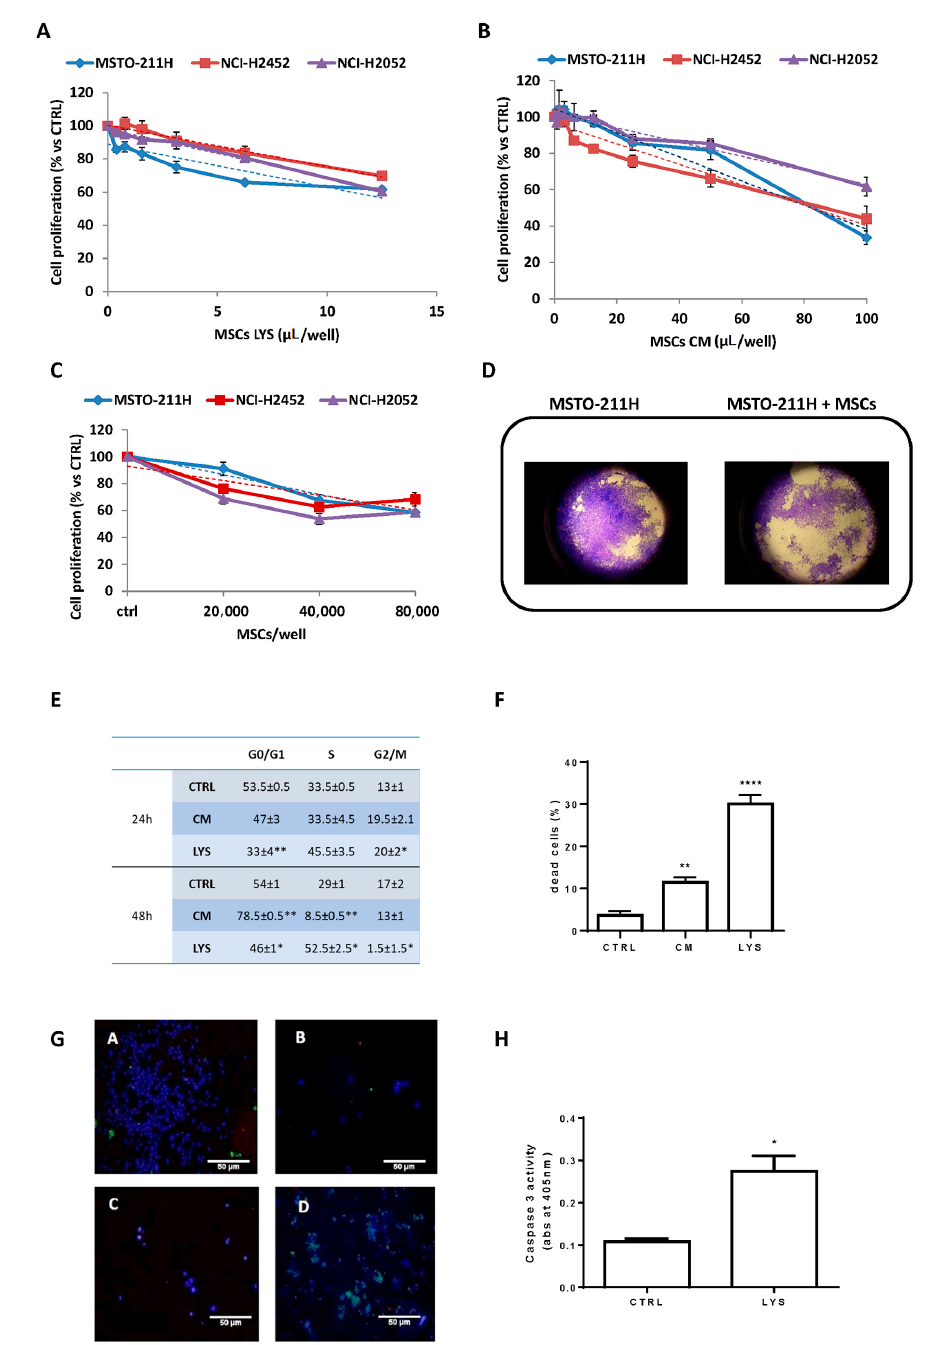
Figure 1. Inhibitory effect of MSCs LYS and MSCs CM on mesothelioma proliferation and co-culture assay. The activity on cell proliferation of MSCs LYS ( A ) and MSCs CM ( B ), expressed as µL/well from 3 donors of adipose tissue-derived MSCs, were evaluated after 7 days in MSTO-211H, NCI- H2452 and NCI-H2052 cell lines by an MTT assay. Each point represents the mean ± standard error (SEM) of three replicates. Linear regression was reported (dashed lines). ( C ) MSTO-211H, NCI-H2452 and NCI-H2052 cells were co-cultured with MSCs and after 5 days, cell proliferation was evaluated by a crystal violet assay. Data are means ± SEM of six independent replicates. Linear regression